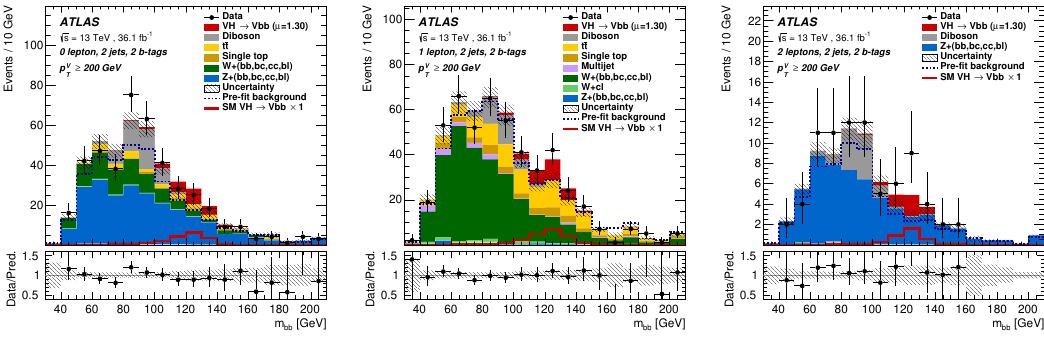
Figure 7 . The m bb distributions in the 0-lepton (left), 1-lepton (middle) and 2-lepton (right) chan- nels for 2- b -tag events, in the 2-jet categories for p V > 200 GeV. The background contributions after T the global likelihood (cid:12)t are shown as (cid:12)lled histograms. The Higgs boson signal ( m H = 125 GeV) is shown as a (cid:12)lled histogram on top of the (cid:12)tted backgrounds normalised to the signal yield extracted from data ( (cid:22) = 1 : 30), and unstacked as an un(cid:12)lled histogram, scaled by the factor indicated in the legend. The dashed histogram shows the total background as expected from the pre-(cid:12)t MC simulation. The size of the combined statistical and systematic uncertainty for the sum of the (cid:12)tted signal and background is indicated by the hatched band. The ratio of the data to the sum of the (cid:12)tted signal and background is shown in the lower panel.